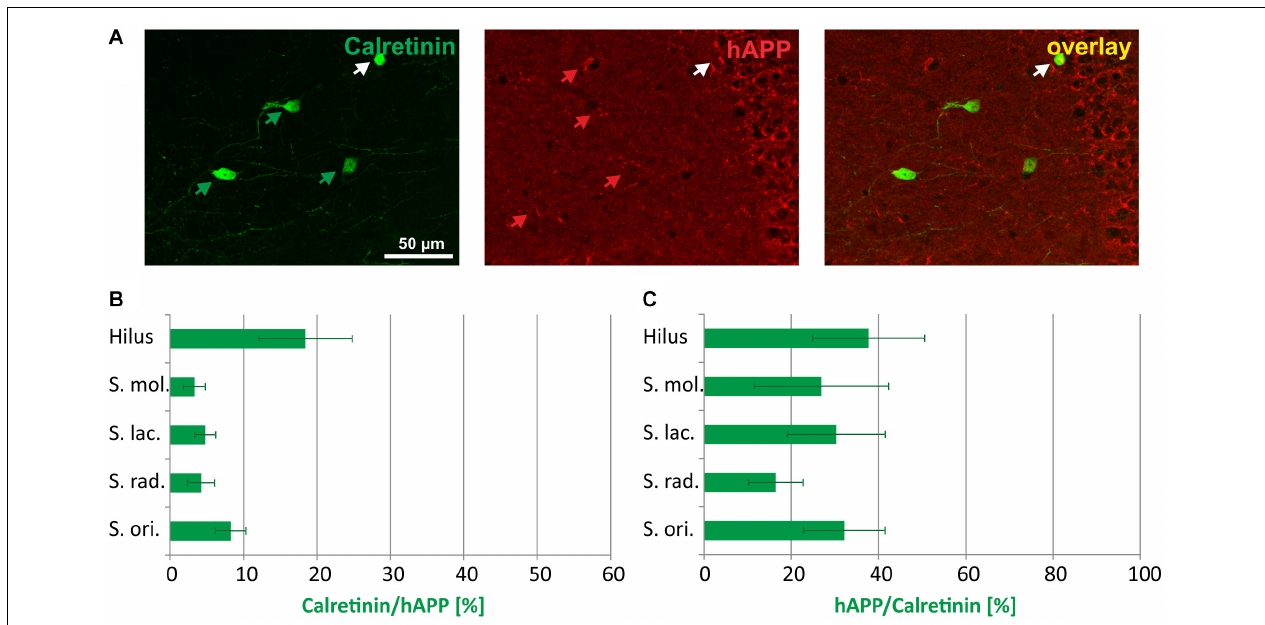
FIGURE 4 | Quantitative analyses of the co-localization between calretinin-immunoreactive neurons and hAPP-expressing interneurons in hippocampus of Tg2576 mice. Typical examples of double labelings in stratum radiatum are shown in panel (A) . White arrows point to double-labeled neurons, green, and red arrows to neurons that are only labeled by green (calretinin) and red (hAPP) fluorescence, respectively. Quantitative analysis revealed that of all hAPP transgene-expressing interneurons 4% (in stratum moleculare ) to 18% (in DG hilus) were calretinin-immunoreactive (B) . Of all calretinin-expressing neurons, 18 to 38% expressed the hAPP transgene in defined hippocampal layers (C) .